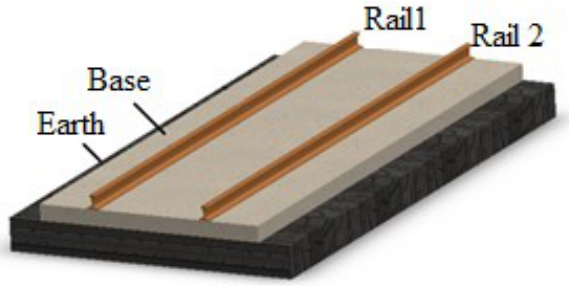
Fig. 1. Schematic diagram of single track